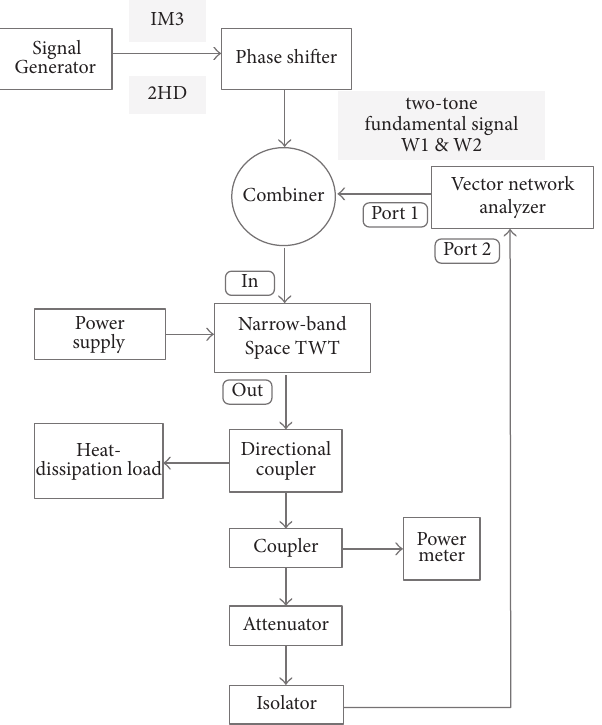
Figure 9: The experiment block diagram of simultaneous suppres- sions in both IMD3 and IMD5.